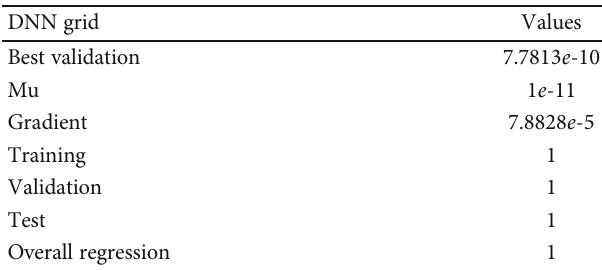
Table 3: DNN data of a controller for the grid